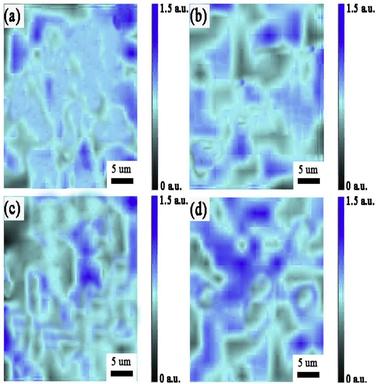
Raman mapping of IG/ID ratio (a) D@C-0.25, (b) D@C-0.5, (c) D@C-0.75, (d) D@C-1.0.